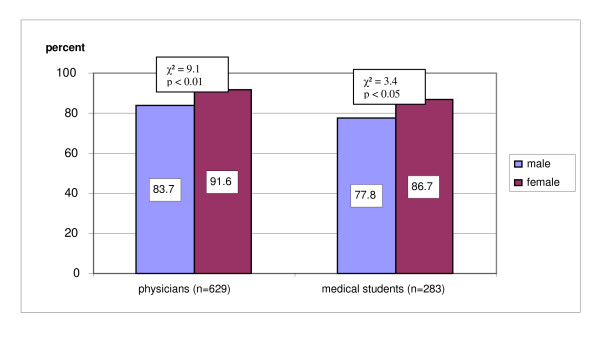
Proportions of female and male non-smokers among medical students and physicians.